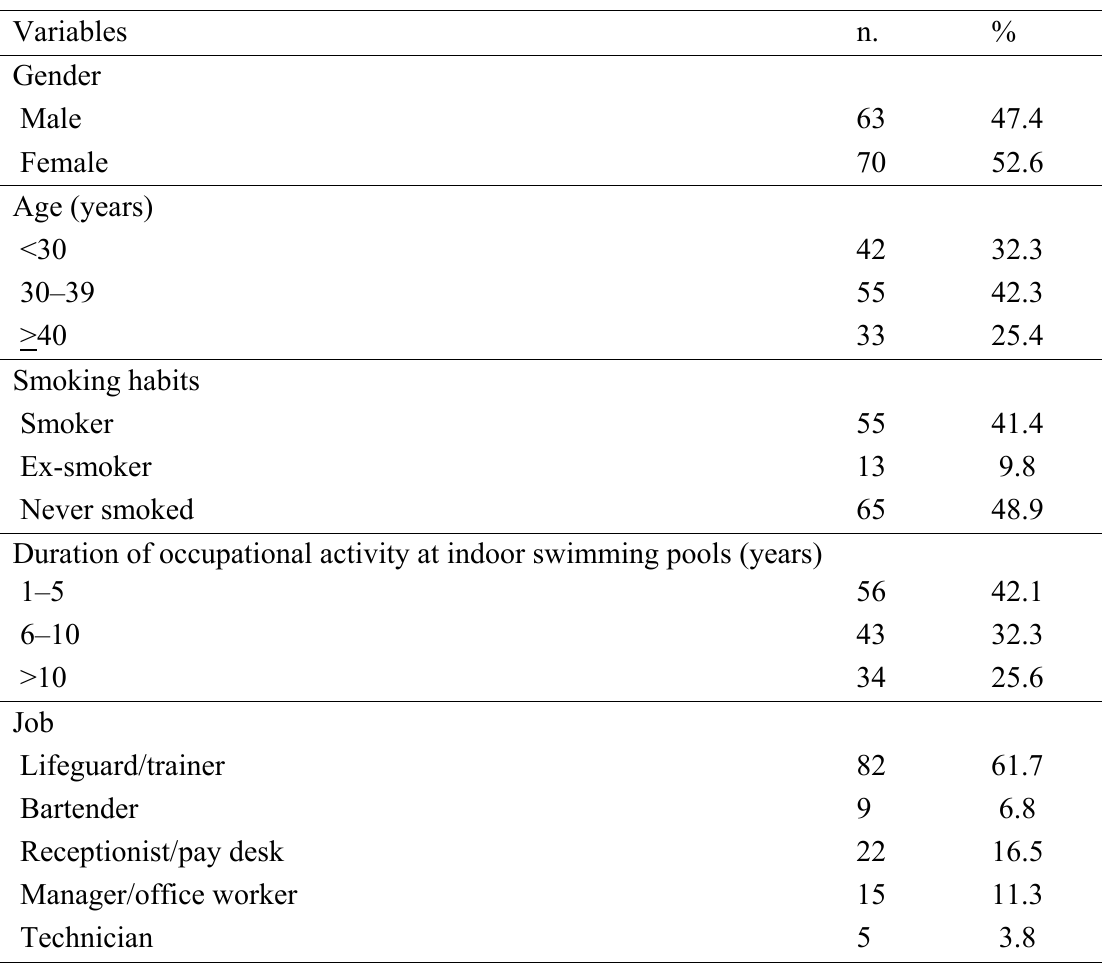
indoor swimming